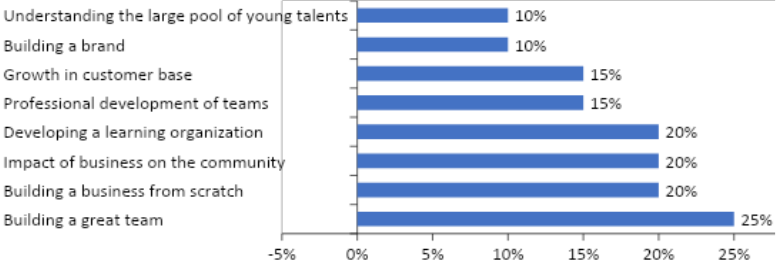
Figure 16: Fulfilling part of their Entrepreneurial